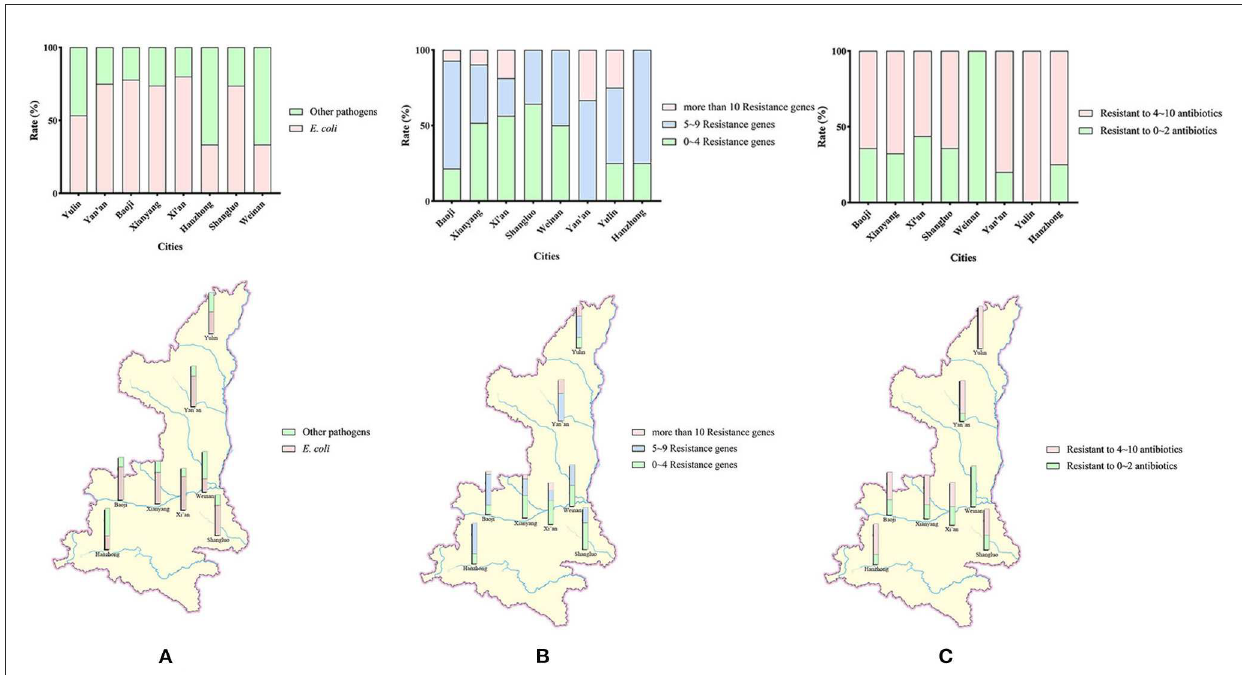
FIGURE1 (A) Geographical distribution of the sampling and detection rates of E. coli isolates. Sources of 158 samples and rates of E. coli detected in 8 cities in Shaanxi Province. (B) Detection rates and regional distribution of E. coli isolates carrying different numbers of antibiotical genes. (C) Detection rates and regional distribution of MDR E. coli